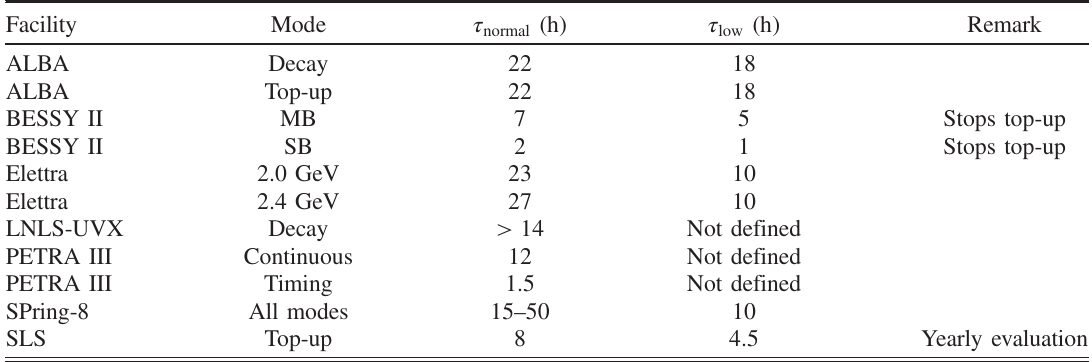
TABLE V. Low-beam-lifetime